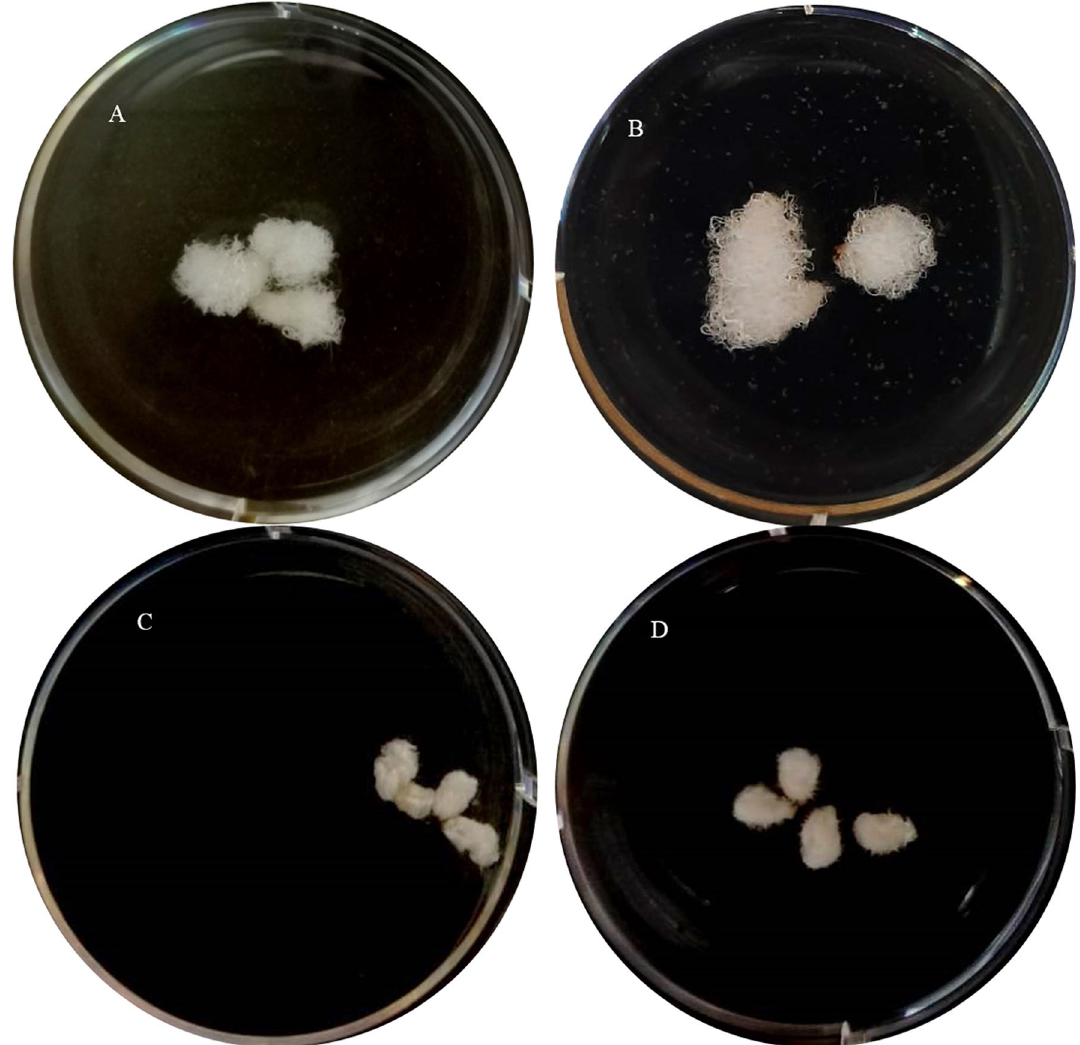
Figure 10. Ovule cultures of G. barbadense in modified BT medium 22 at 21 DPA ( A ) control BT without any supplement ( B ) medium supplemented with 10 µM ACC ( C ) 40 µM of CoCl 2 ( D ) 30 µM of AgNO 3